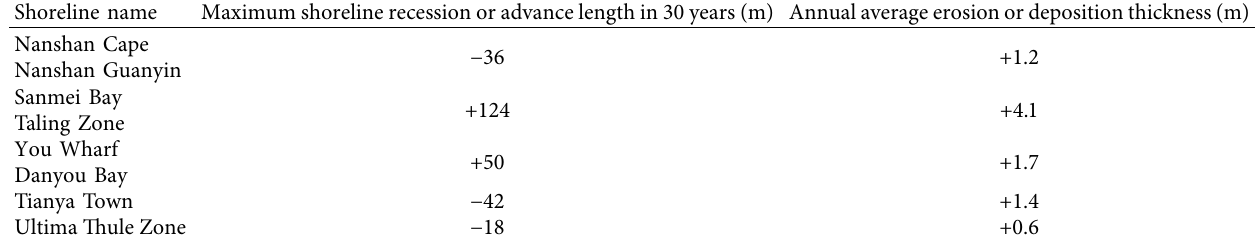
Table 3: Shoreline evolution after SSRA.